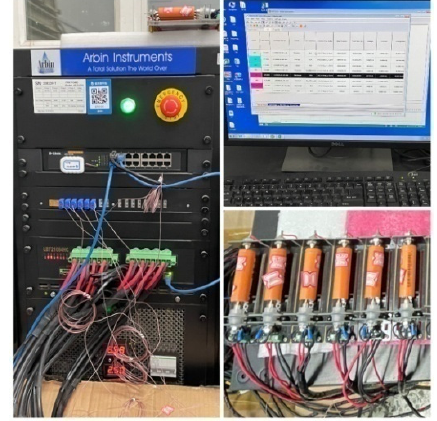
Figure 2. Arbin BT-ML-30V/10A battery tester.